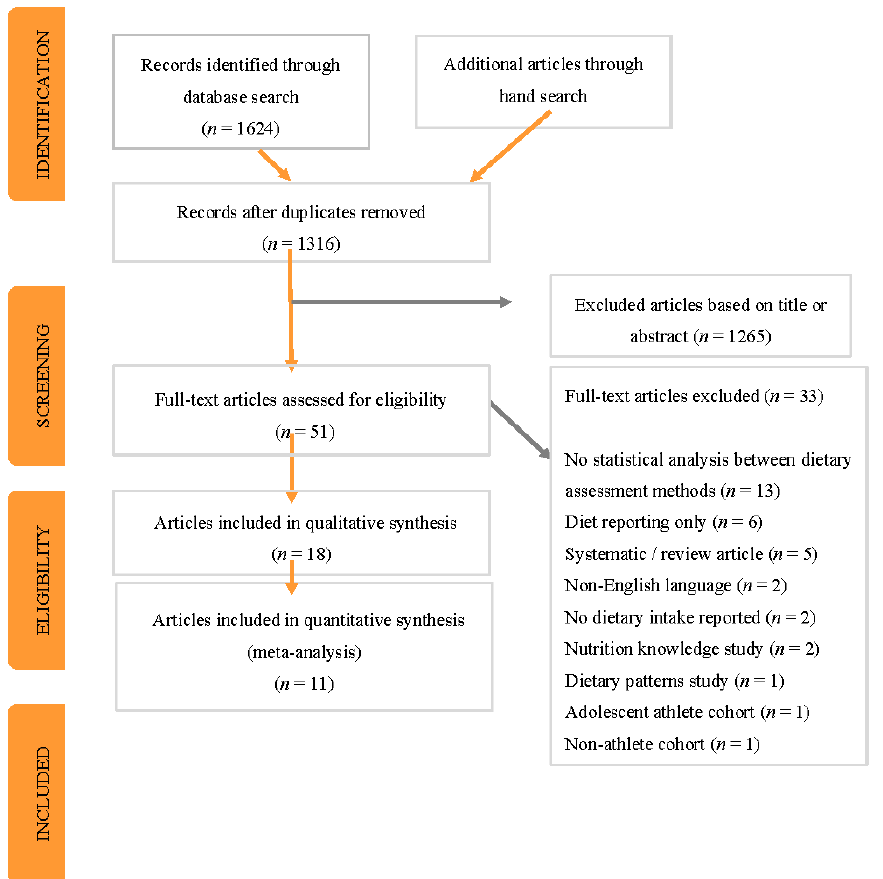
Figure 1. Preferred Reporting Items for Systematic Reviews and Meta-Analyses (PRISMA) flow diagram of identification, screening and selection process for included articles.